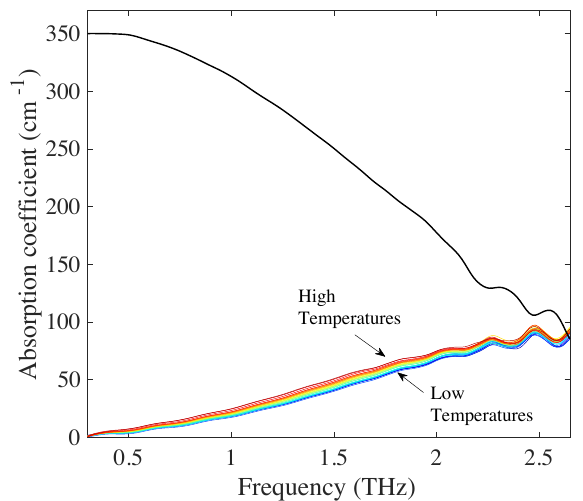
Figure 3. Absorption coefficient spectra of high MW PLGA 75:25 in the temperature range of 100–350 K, with 10K temperature increments between spectra. Solid black line indicates the maximum absorption